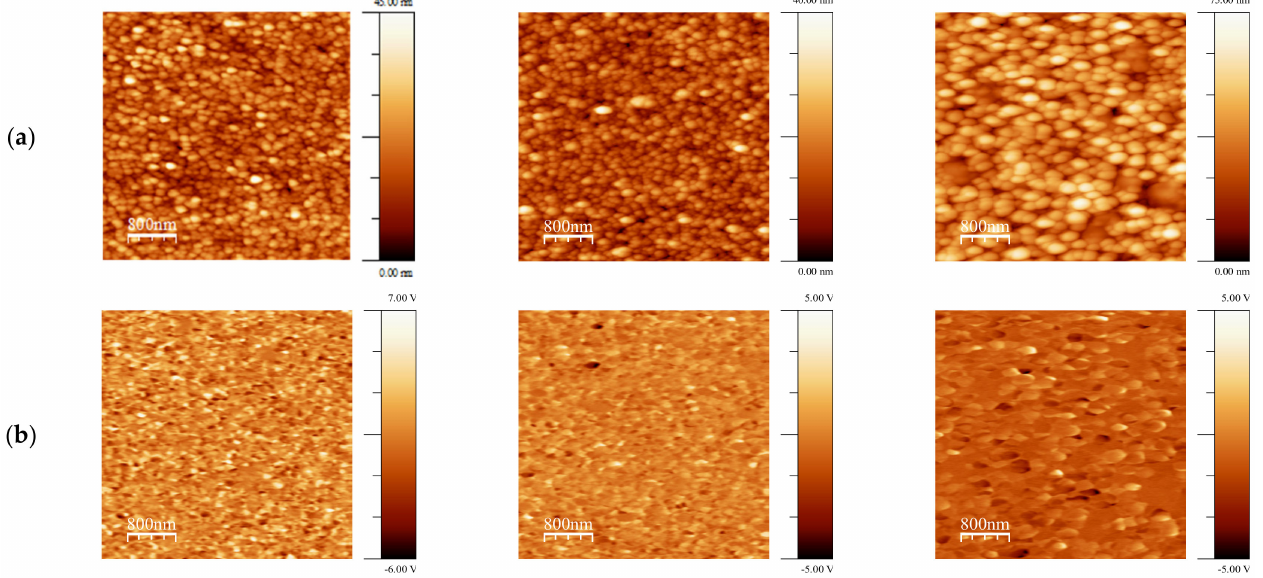
Figure 4. ( a ) Topography, ( b ) OPP PFM of Bi 0 . 9 La 0.1 FeO 3 sol–gel films annealed at 550 ◦ C ( left column ), 600 ◦ C ( middle column ) and 700 ◦ C ( right column